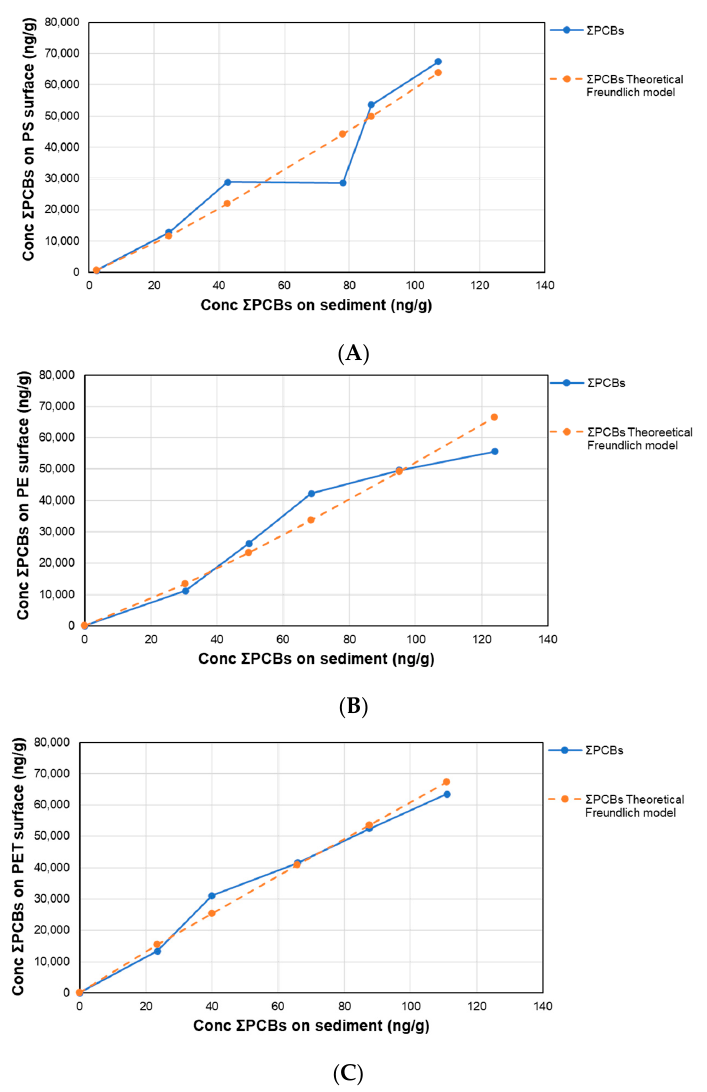
Figure 1. Adsorption isotherms of concentration (Conc) of Ʃ PCBs after 21 days on MPL surface of ( A ) PS, ( B ) PE, and ( C ) PET vs. sediment.